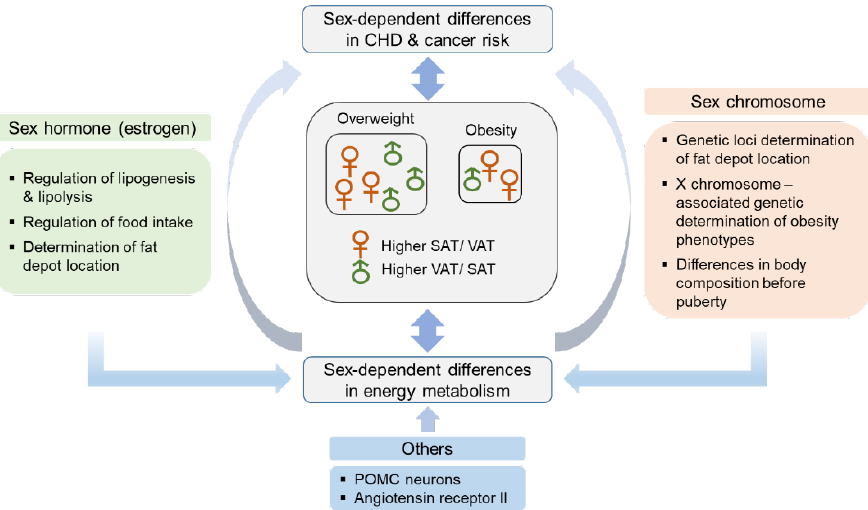
Figure 1. Factors contributing to sex differences in obesity. More women than men in the general population are obese, possibly because of a longer life expectancy in women and a rapid increase in obesity rate in postmenopausal women than in men. Sex differences in energy metabolism are contributed by not only sex hormone but also X chromosome gene expression, and expression of other genes, such as those for POMC and angiotensin receptor II. These factors regulate energy metabolism, leading to sex differences in the incidence of obesity and obesity-associated diseases. CHD, cardio- vascular heart disease; POMC, pro-opiomelanocortin; SAT, subcutaneous adipose tissue; VAT, visceral adipose